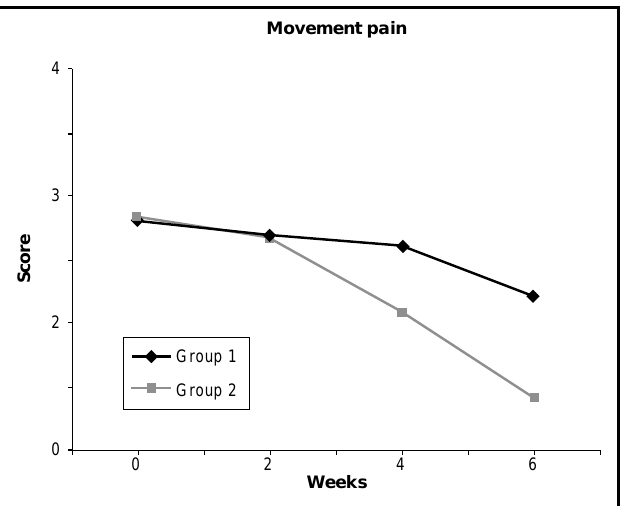
Figure 12: Development of resting pain for the six week-course of treatment in the therapy